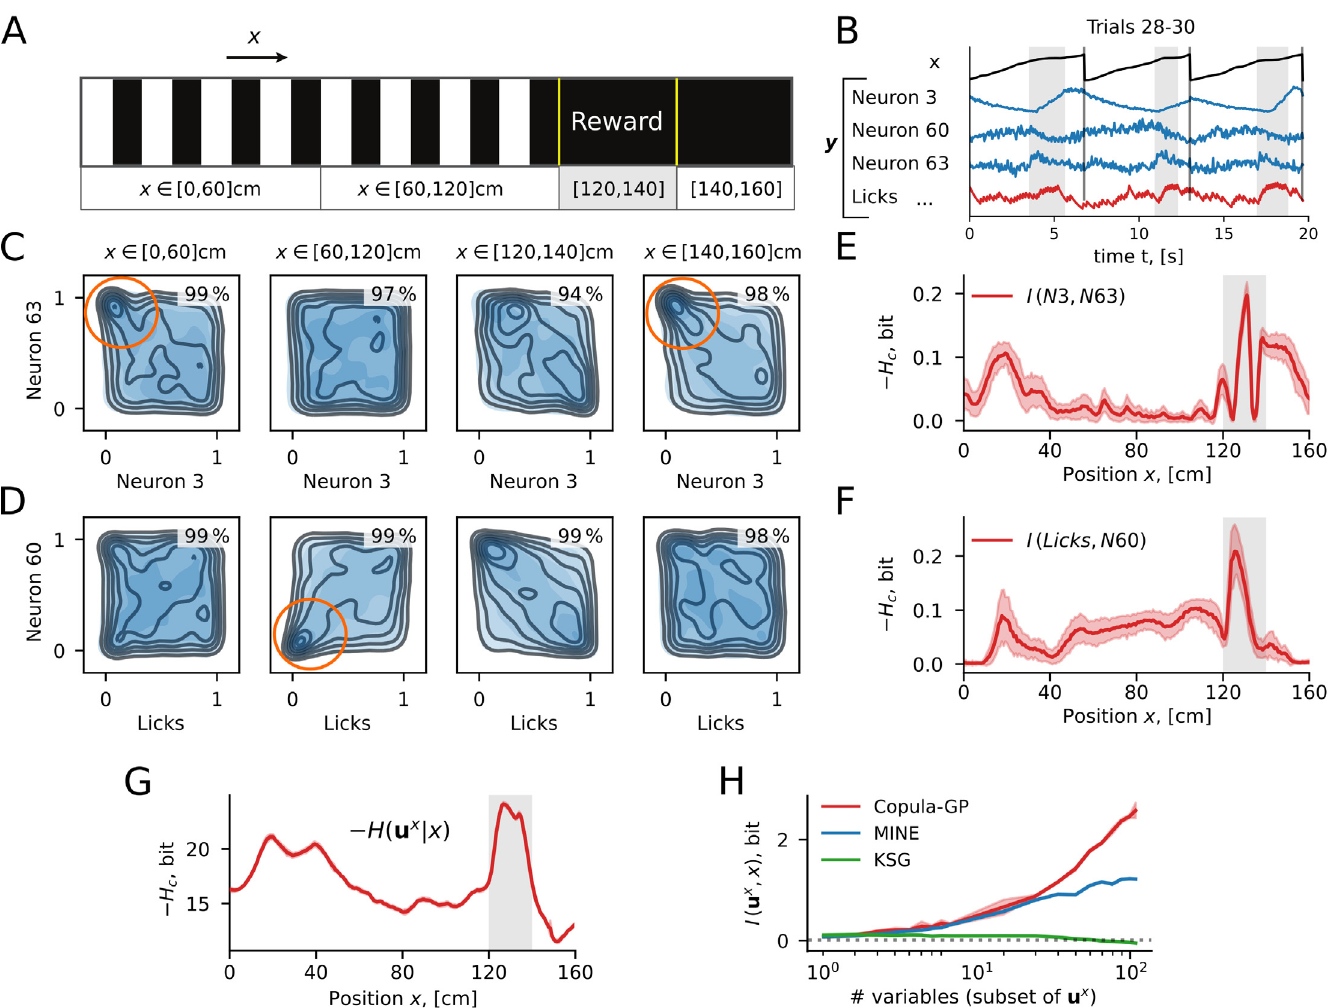
Fig 5. Validation of Copula-GP method on neuronal population activity and behavioral variables from awake mice. Copula-GP accurately models the neuronal and behavioral heavy tailed dependencies in the data from the visual cortex of awake mice, and quantifies more mutual information between various combinations of variables than the alternative methods. A Schematic of the navigational experimental task [5, 16] in virtual reality; B Example traces from ten example trials: x is a position in virtual reality, y is a vector of neuronal (blue) and behavioral (red) variables; these traces show that variables have different timescales and different signal-to- noise ratios, which result in different distributions of single variables y i (i.e. different marginal statistics). C-D Copula probability density plots for: the noise correlation between two neurons (number 3 and 63) (C) and for the correlation between one neuronal activity (60) vs. one behavioral variable (licks) (D); Black outlines show empirical copula, shades of blue—the best fitting Copula-GP model: a mixture of Gaussian + 90˚-rotated Clayton copula in (C) and a mixture of Frank + 0˚-rotated Clayton + 270˚-rotated Gumbel copula in (D) (see S4 Text for model parameters). Similarly to the example with two dynamically coupled neurons (Fig 3G), these copulas are heavy-tailed. The goodness-of-fit for these models is measured with the proportion of the variance explained R 2 , which is indicated in the upper-right corner of each plot corresponding to a range of positions in virtual reality; E-G Conditional entropy for the bivariate examples (E-F) and the population-wide statistics (G) all peak in the reward zone; this entropy is equivalent to the mutual information between variables, given the position x , which means that the variables carry the most information about each other when the animal is in the reward zone. H Comparison of Copula-GP method (“integrated”) vs. non-parametric MI estimators (MINE [55] and KSG [53]) on estimating the amount of information about the location x from the subsets of variables u x . While the true I ( x , u x ) is unknown, the validation on synthetic data (Fig 4) suggest that Copula-GP “integrated” does not overestimate the amount of mutual information. Yet, Copula-GP “integrated” quantifies more information about the position x from the large subsets of data u x than MINE and KSG